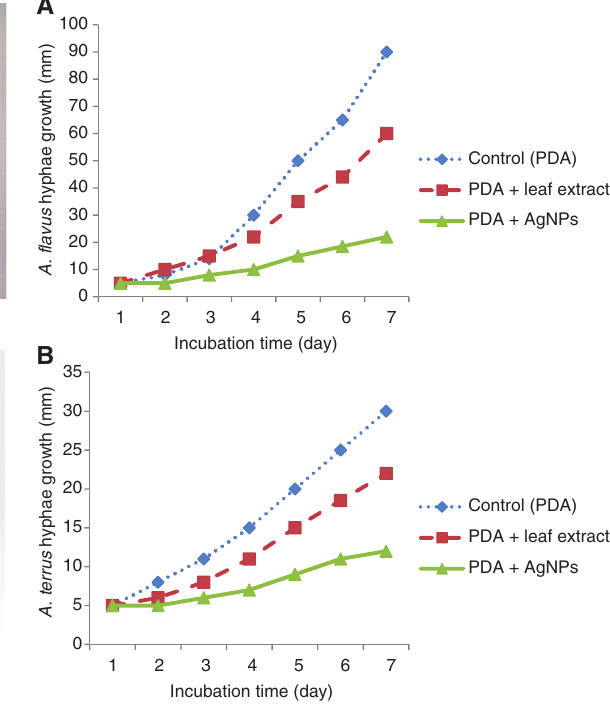
Figure 8: Antifungal activity of the synthesized AgNPs at obtained optimum conditions against Aspergillus flavus (A) and Aspergillus terreus (B). Data are the mean value of three replicates (each repli- cate contains four plates).